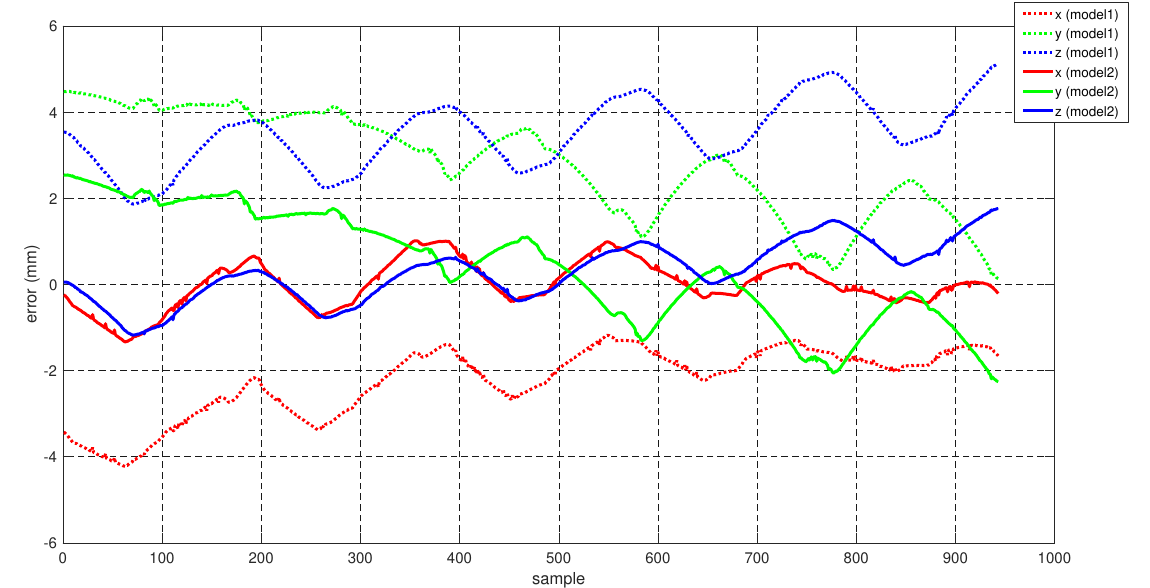
Figure 18. Comparison of the error along the coordinates axes for Model 1 and Model